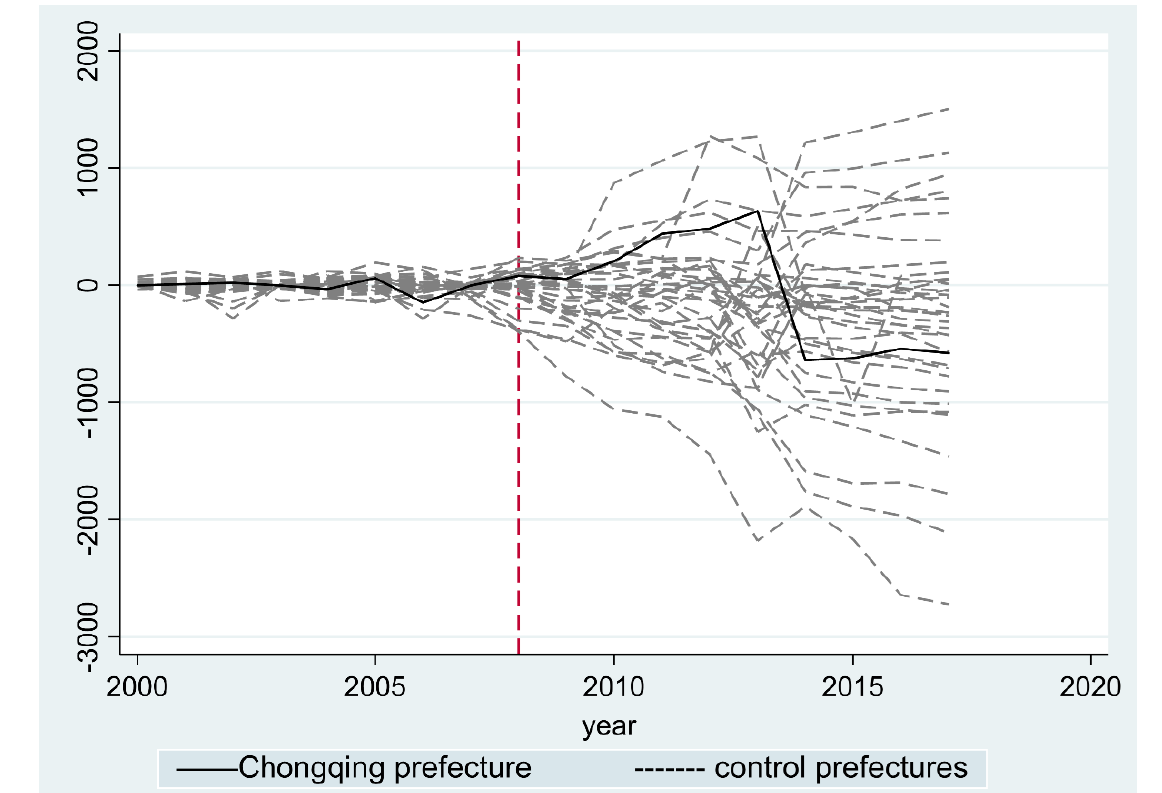
Figure 6. Robustness test result.